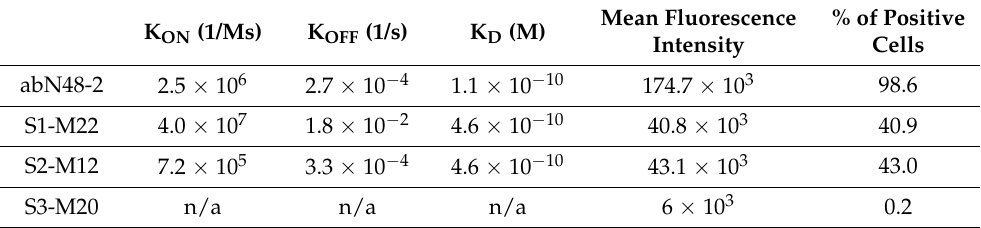
Table 3. Experimental binding assays on the antibodies resulting from in silico maturation. K ON , K OFF , and K D values were obtained using SPR. After fitting the data in Figure 1, the predicted values for the K D were 2.8 × 10 − 10 , 1.0 × 10 9 , and 2.6 × 10 − 10 for S1-M22, S2-M12, and S3-M20, respectively. The geometric mean fluorescence intensity and positive cell percentage (gated by the dashed line) of each group shown in Figure 5B are shown in the last two